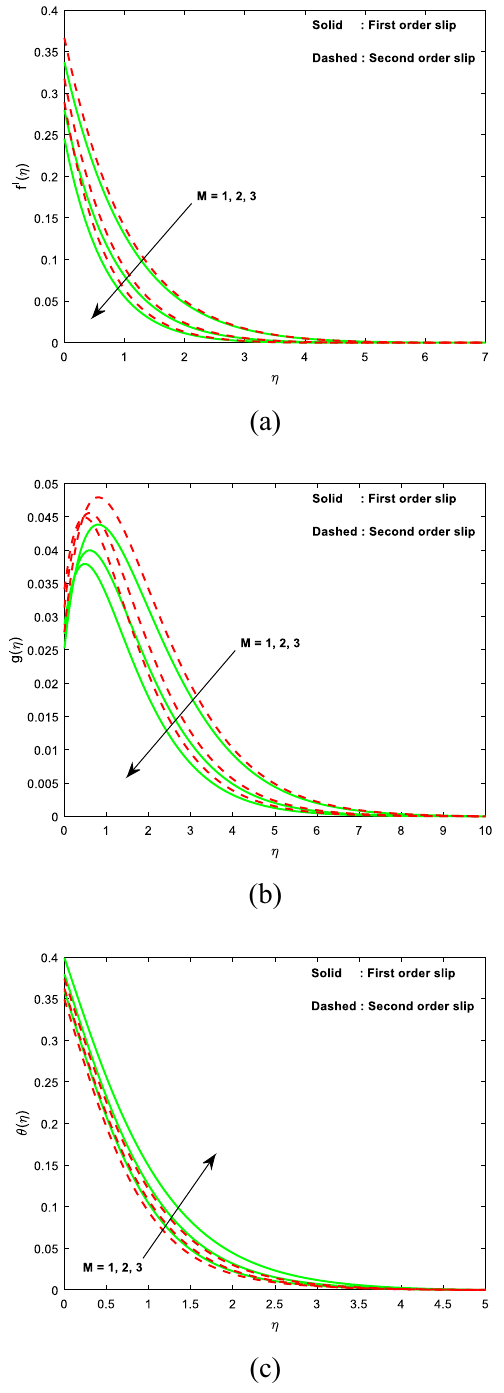
Figure 2. Impact of M on ( a ) velocity ( b ) microrotation ( c )